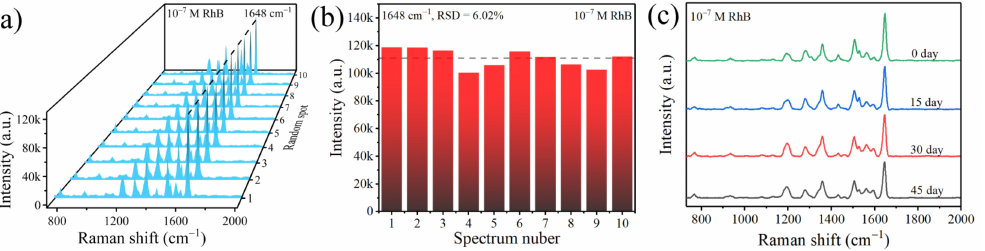
Figure 9. ( a ) SERS spectra obtained by randomly measuring 10 points on the ZnO/Ag2 substrate. ( b ) SERS intensity of 10 − 7 M RhB solution at 1648 cm − 1 of the 10 SERS spectra. ( c ) SERS spectra of 10 − 7 M RhB based on ZnO/Ag2 were collected at different shelf